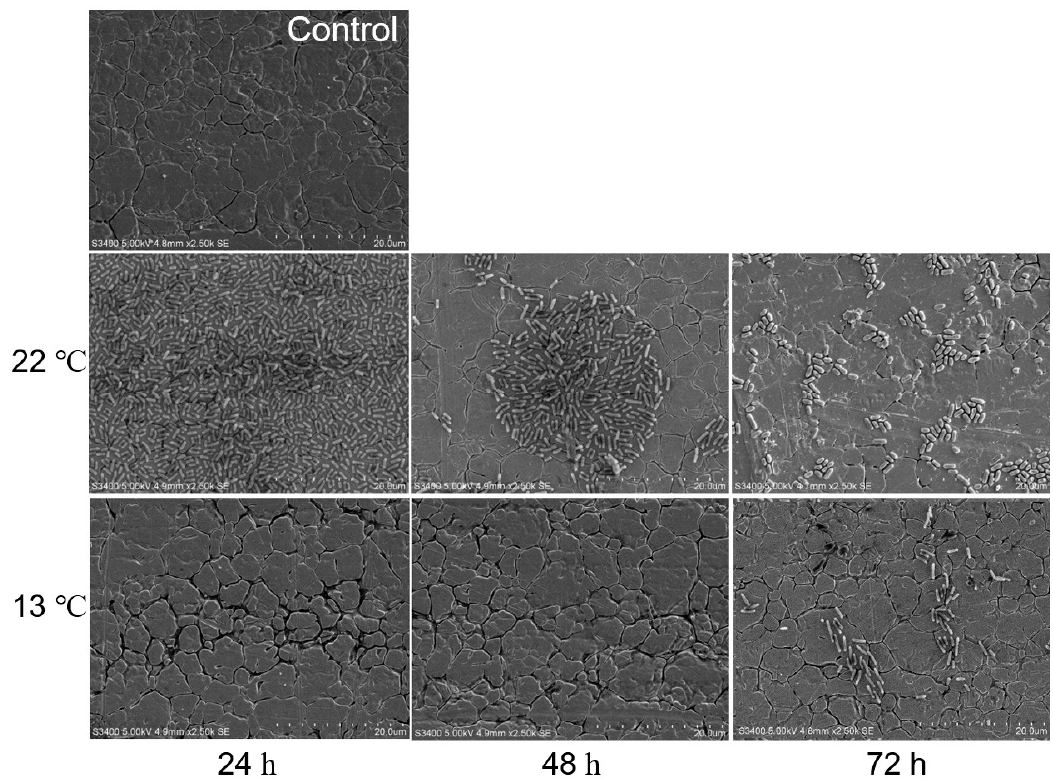
Figure 5. Representative SEM images of O91 biofilm grown in M9 medium at 22 °C and 13 °C for 24, 48, and 72 h on stainless steel coupons. Bar = 20 µm.